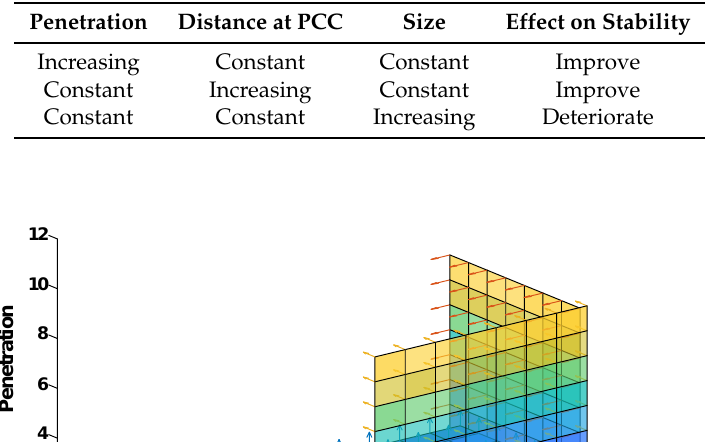
Table 3. Effect of different parameters on stability.